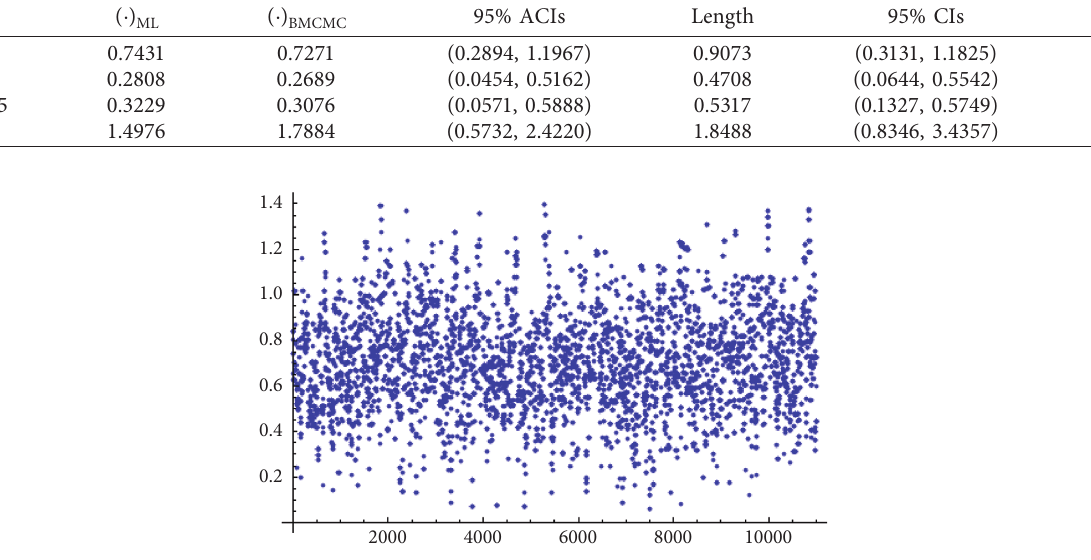
Figure 1: Simulation number of α generated by the MCMC method.